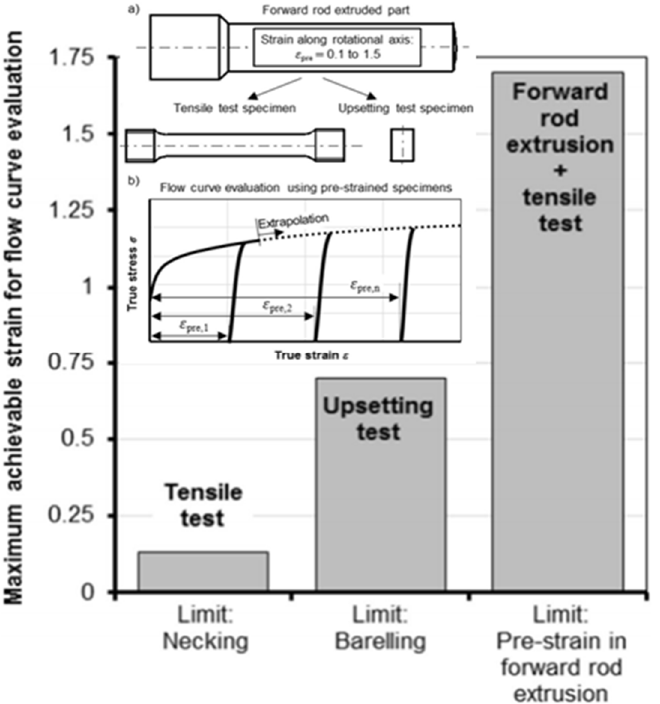
Figure 13. Strain limit of testing methods in calculating the flow stress [28]: ( a ) Test specimen; ( b ) Flow curve evaluation using pre-strained specimens.